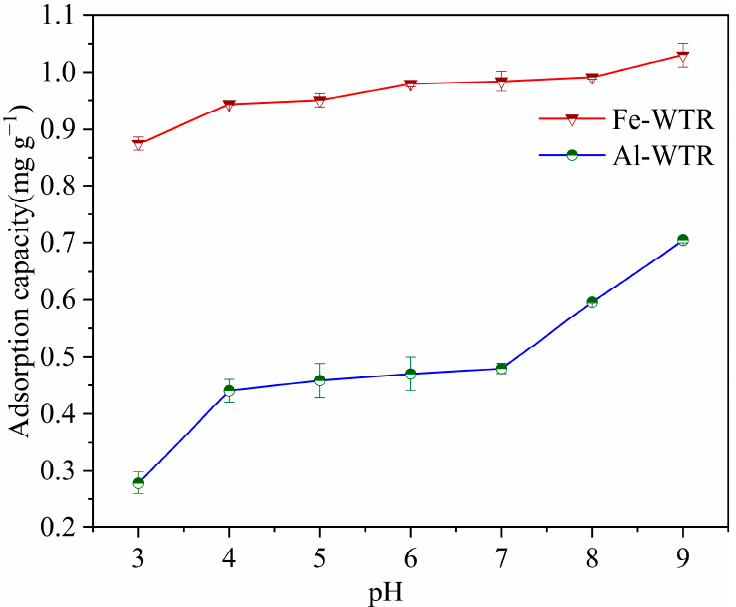
Figure 3. Effect of Fe-WTR and Al-WTR on Tl(I) adsorption under different pH conditions.